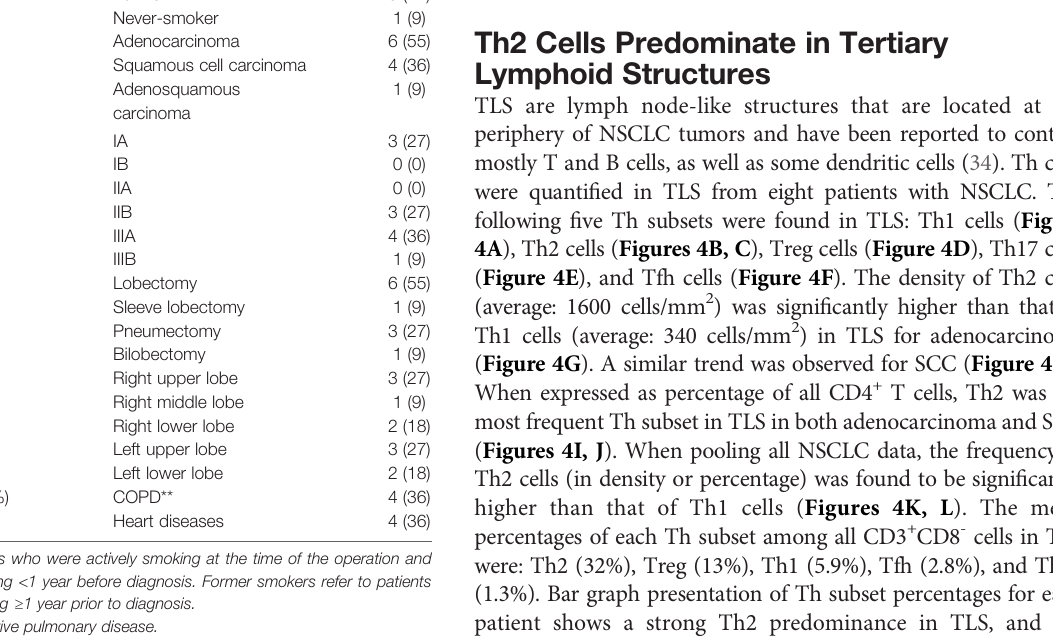
( Figure 4G ). A similar trend was observed for SCC ( Figure 4H ).